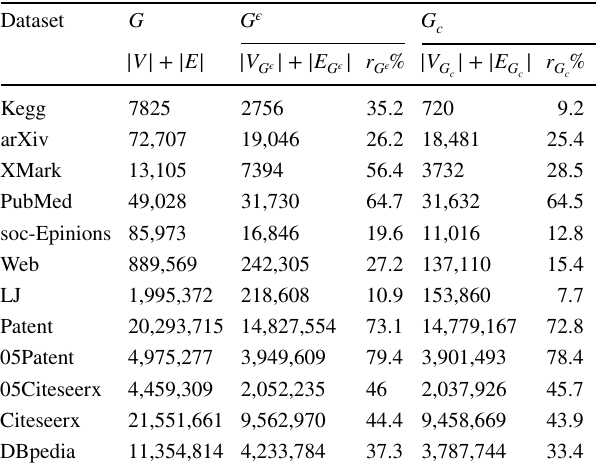
Table 2 Graph size before and after compression